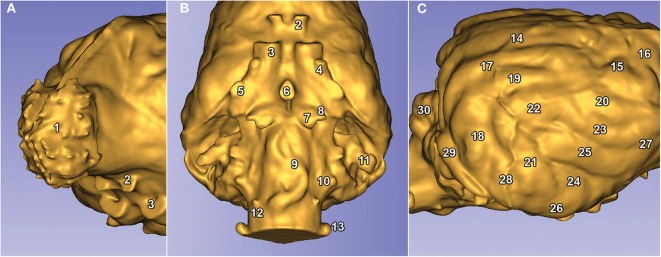
Visible structures on a Weimaraner's endocast. (A) Left rostro-lateral view. (B) Ventral view. (C) Right caudo-lateral view. The numbers represent the structures of the brain. (1) Bulbus olfactorius. (2) Canalis opticus. (3) Fissura orbitalis. (4) Foramen rotundum. (5) Foramen ovale. (6) Dorsum sellae. (7), Canalis petrooccipitalis. (8) Foramen caroticum. (9) Impression of the A. basilaris cerebri on the medulla oblongata. 10) Foramen jugulare. (11) Fossa subarcuata. (12) Canalis nervi hypoglossi. (13) Canalis condylaris. (14) Gyrus marginalis. (15) Gyrus postcruciatus. (16) Gyrus precruciatus. (17) Gyrus ectomarginalis. (18) Gyrus suprasylvius caudalis. (19) Gyrus suprasylvius medius. (20) Gyrus suprasylvius rostralis. (21) Gyrus ectosylvius caudalis. (22) Gyrus ectosylvius medius. (23) Gyrus ectosylvius rostralis. (24) Gyrus sylvius caudalis. (25) Gyrus sylvius rostralis. (26) Gyrus compositus caudalis. (27) Gyrus compositus rostralis. (28) Impression of the A. meningea media. (29) Sinus transversus. (30) Vermis cerebelli.